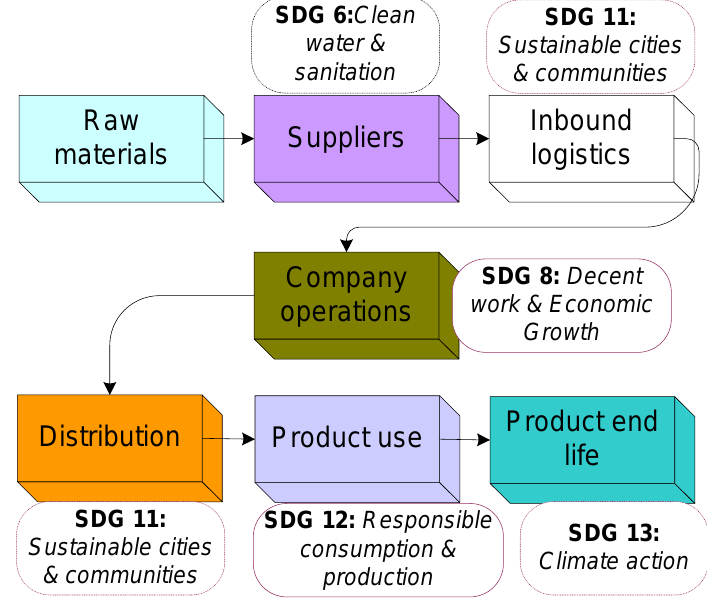
Figure 4. Mapping of SCM with SDGs.